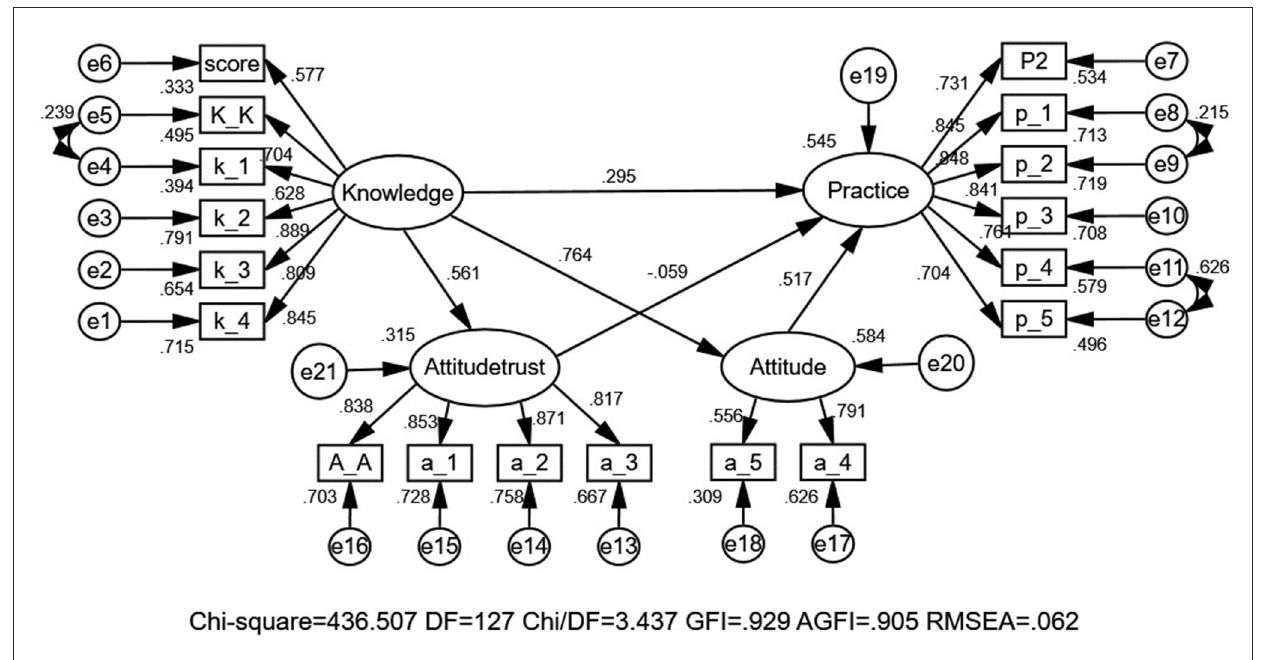
FIGURE2 The KAP structural equation model of the nutrition label.